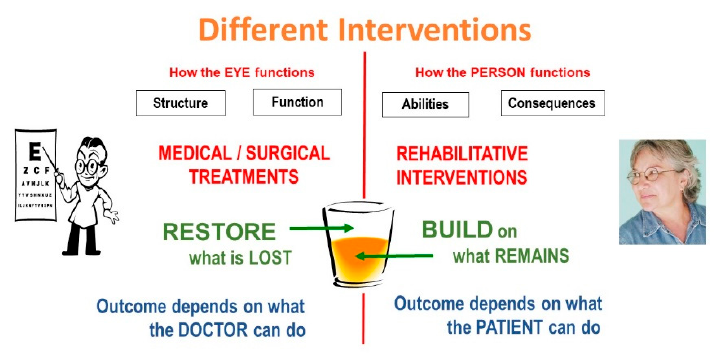
Figure 2. The role of rehabilitation.